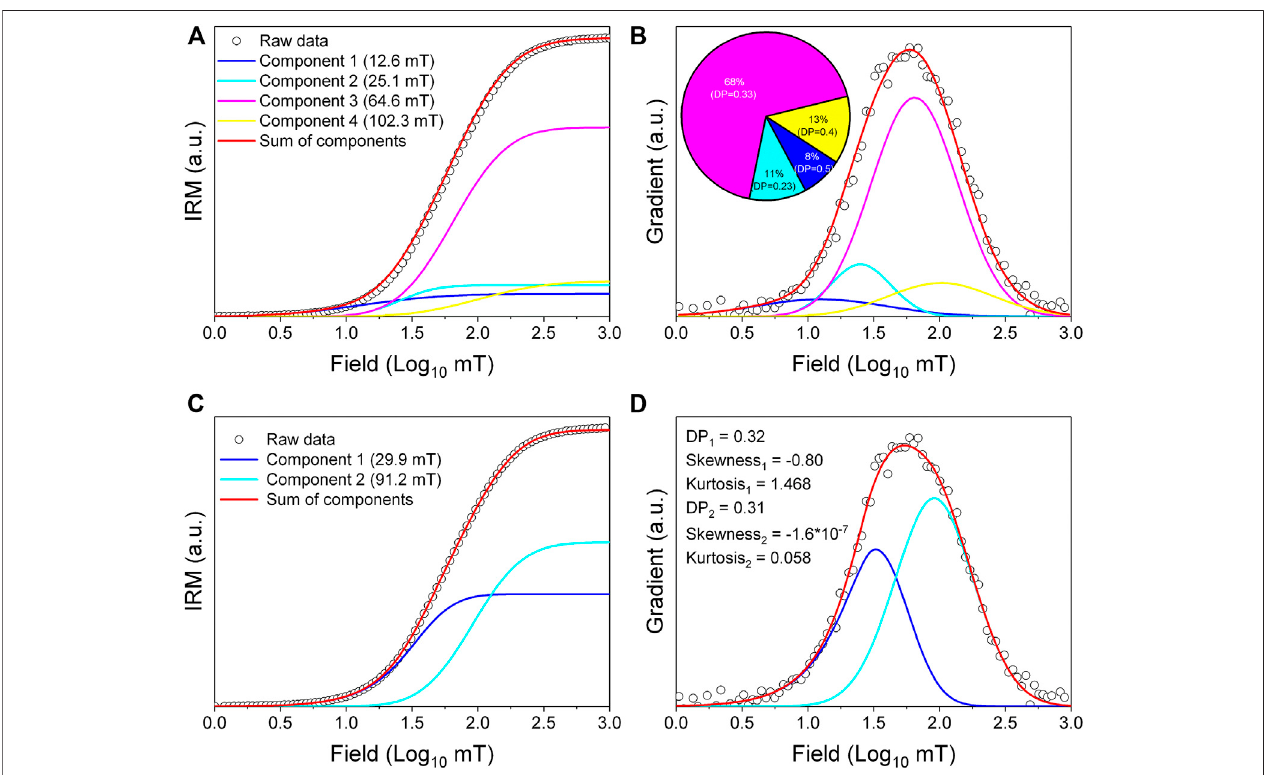
FIGURE 11 | Alternative IRM component analysis based on unsupervized fi tting of coercivity distributions with (A , B) CLG functions (e.g., Kruiver et al., 2001) and (C,D) SGG functions (Egli, 2003). Left-hand column: linear acquisition plots; right-hand column: gradient of acquisition plots.